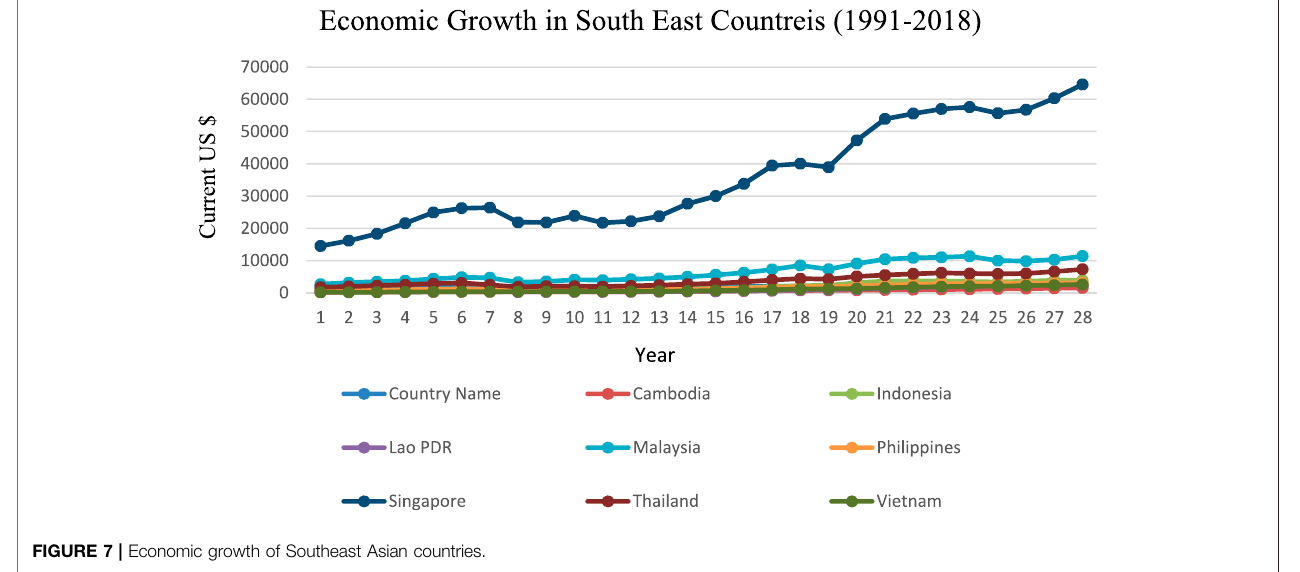
FIGURE 7 | Economic growth of Southeast Asian countries.